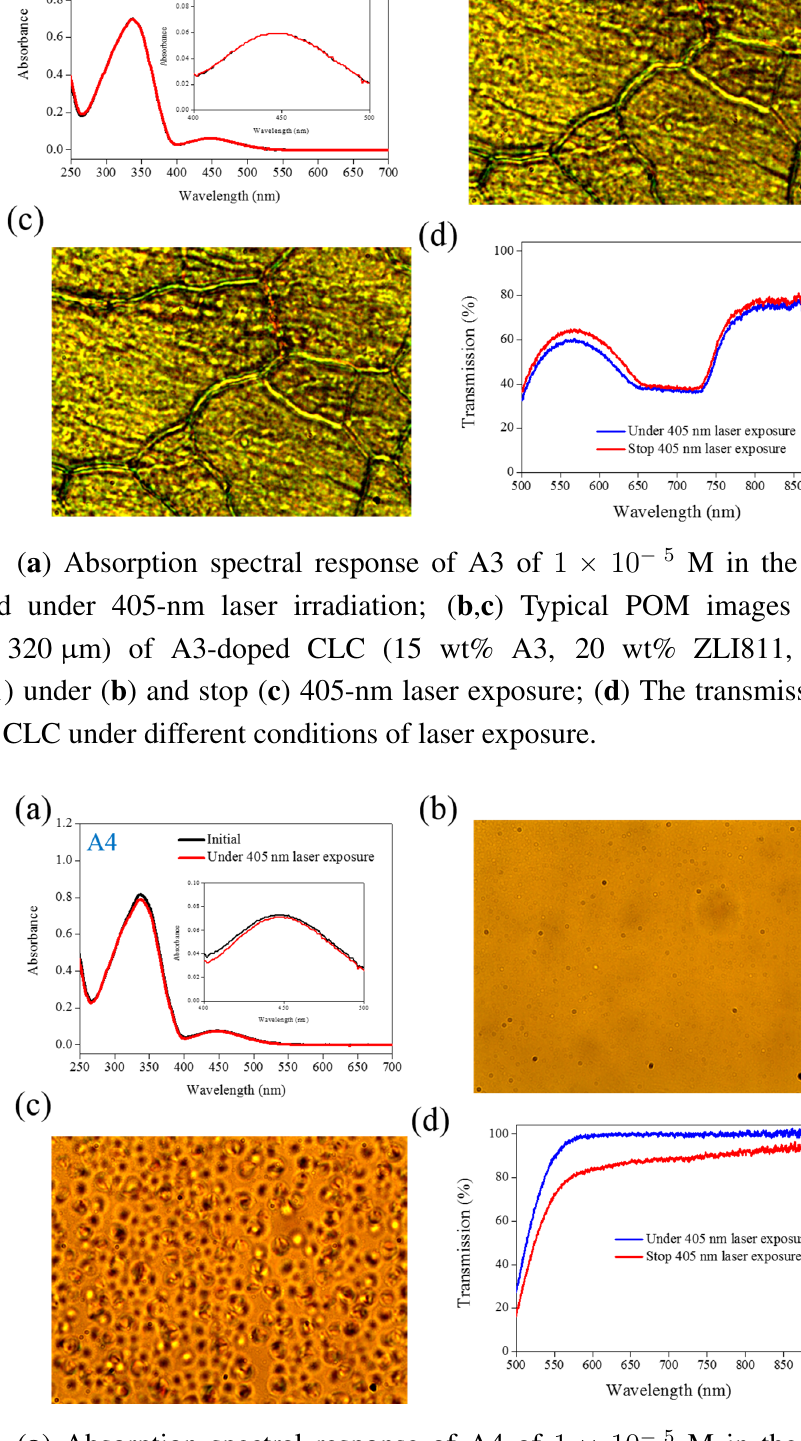
Figure 4. ( a ) Absorption spectral response of A4 of 1 ˆ 10 ´ 5 M in the THF solution before and under 405-nm laser irradiation; ( b , c ) Typical POM images (picture area: 270 μ m × 320 μ m) of A4-doped CLC (15 wt% A4, 20 wt% ZLI811, and 65 wt% MDA3461) under ( b ) and stop ( c ) 405-nm laser exposure; ( d ) The transmission spectra of A4-doped CLC under different conditions of laser exposure.